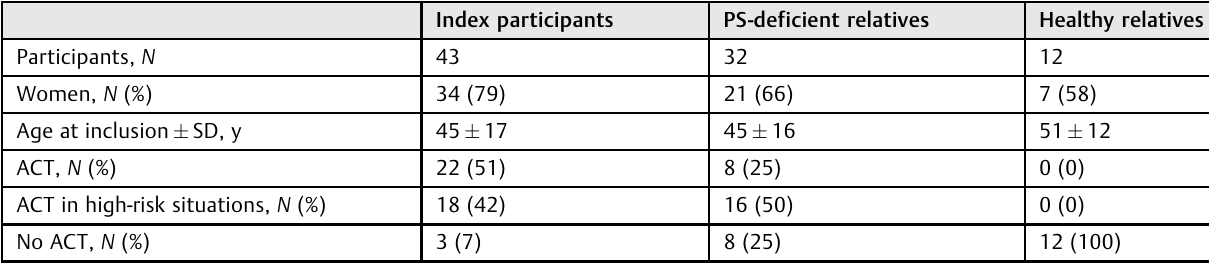
Table 1 Characteristics of the study population